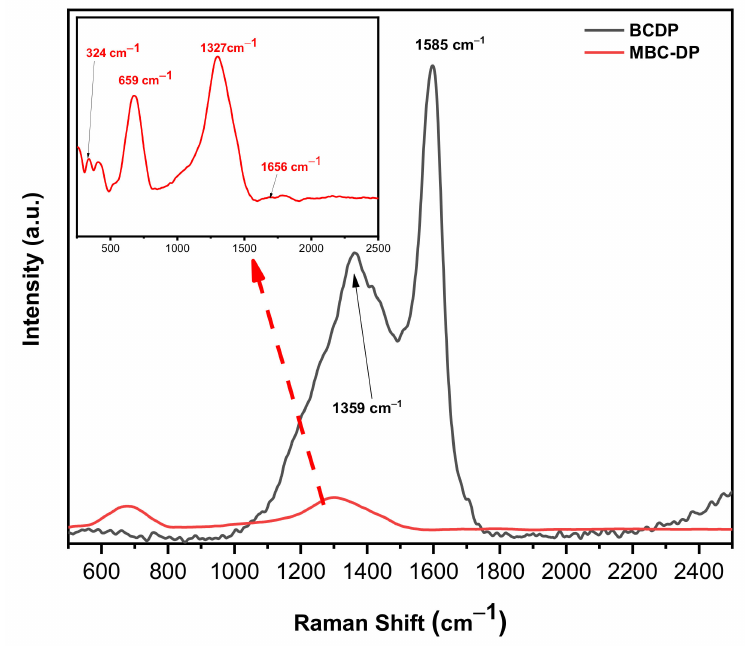
Figure 3. Raman spectra of the as-prepared adsorbents, BCDP and